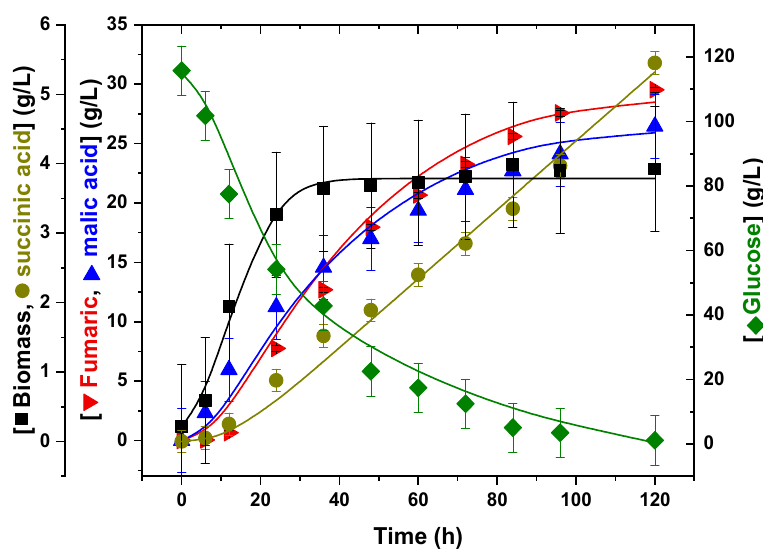
Figure 8. Evolution of biomass, glucose, and products during the production stage. Lines show the fit of the proposed kinetic model to all retrieved data.